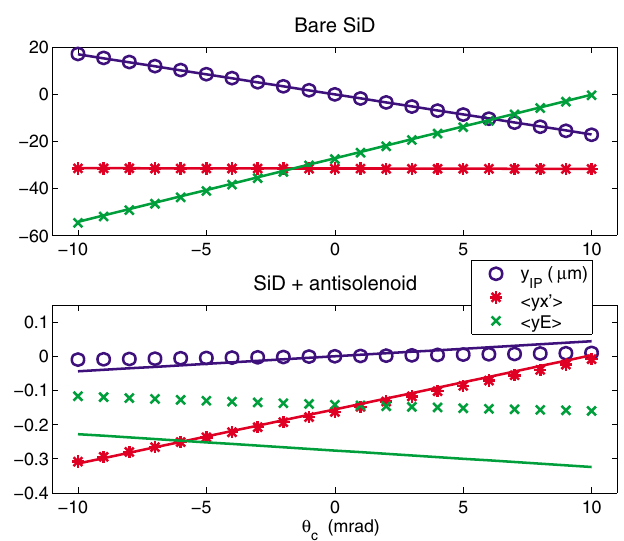
FIG. 17. (Color) Vertical orbit at the IP, and beam distortions h yx 0 i and h yE i in SiD without (top plot) and with antisolenoid (bottom plot) as a function of crossing angle. Symbols: tracking; lines: analytical